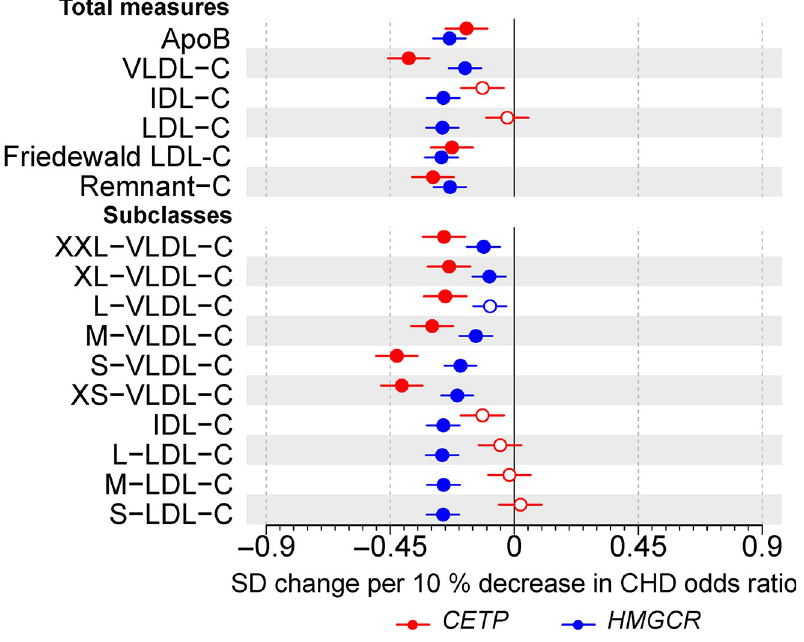
Fig 1. Associations of genetic variants in CETP rs247617 (red) and HMGCR rs12916 (blue) with circulating apolipoprotein B and cholesterol concentrations in size-specific apolipoprotein B particles. Estimates represent the standardized difference in lipoprotein trait, with per allele associations scaled to a 10% lower relative risk of CHD. Analyses were adjusted for age, sex, genotyping batch, and 10 genetic principal components. The circles refer to the effect estimates and the horizontal bars to the 95% CIs. Closed circles represent statistical significance of associations at P < 0.002 and open circles associations that are nonsignificant at this threshold. The lipoprotein subclasses are defined by particle size [17–19]: potential chylomicrons and the largest VLDL particles (XXL-VLDL; average particle diameter � 75 nm); 5 different VLDL subclasses, i.e., very large (average particle diameter 64.0 nm), large (53.6 nm), medium (44.5 nm), small (36.8 nm), and very small VLDL (31.3 nm); IDL (28.6 nm); and 3 LDL subclasses, i.e., large (25.5 nm), medium (23.0 nm), and small LDL (18.7 nm). Underlying data can be found in S1 Data. ApoB, apolipoprotein B; C, cholesterol; CHD, coronary heart disease; IDL, intermediate-density lipoprotein; LDL, low-density lipoprotein; VLDL, very-low-density